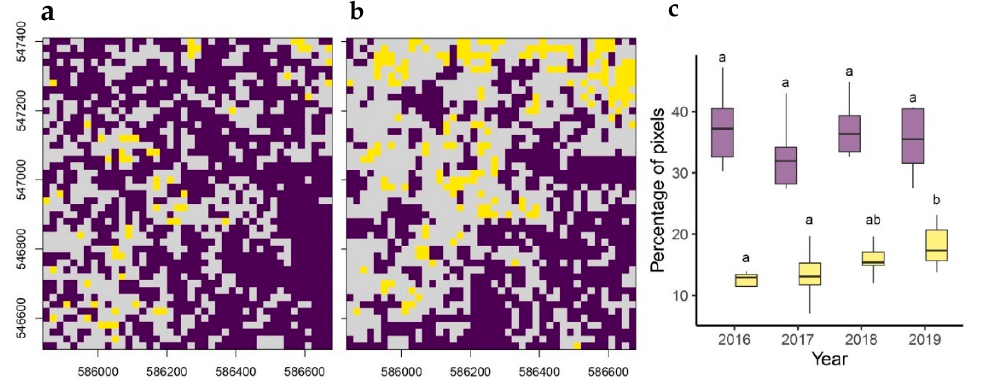
Figure 4. Predicted liana infestation in two classes, Low [ ≤ 25%] (purple) and Severe [ ≥ 75%] (yellow), derived from Sentinel-2 satellite imagery showing an extract from ( a ) 2016, ( b ) 2019. Grey areas correspond to liana infestation values not within low or severe classes (i.e., 26–74%). Panel ( c ) the percentage of pixels within each class for all four years (2016–2019). Letters in ( c ) indicate statistically significant differences between years as assessed using a least significant difference test with Bonferroni adjusted p -values. Significance level was set at